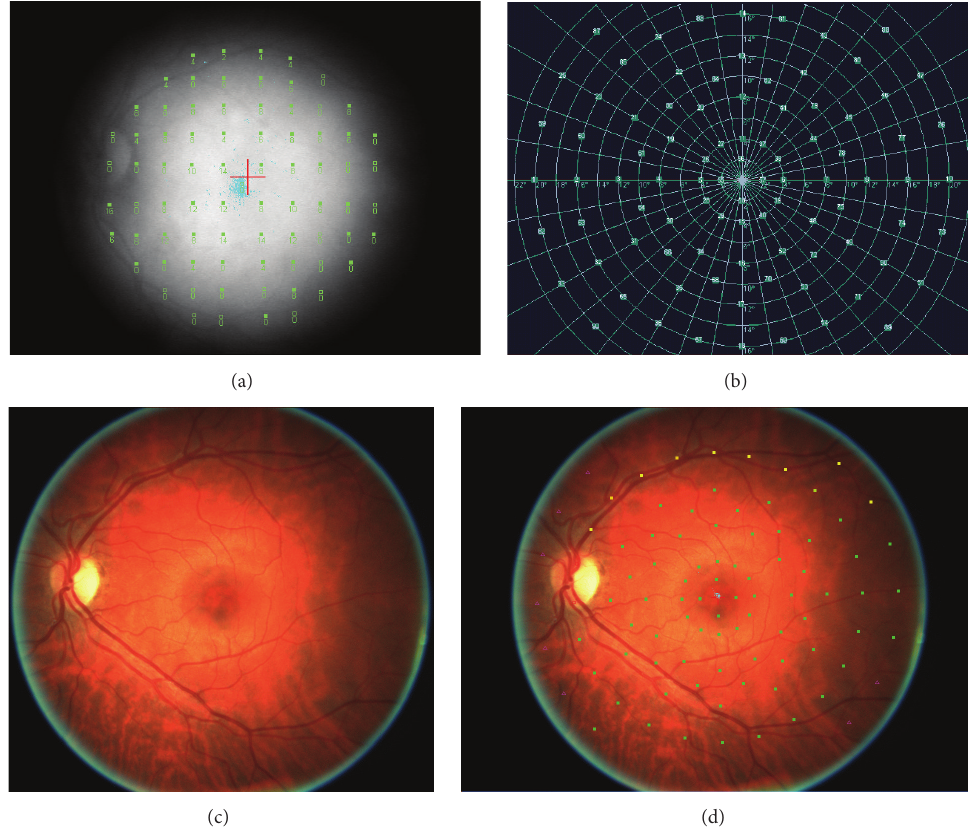
Figure 1: (a) Infrared image of the ocular fundi. (b) Computerized perimetry. (c) Digital image of the ocular fundi. (d) Microperimetric image.